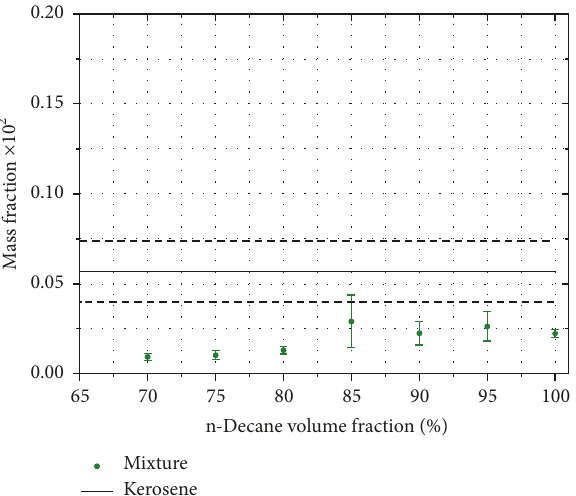
Figure 5: Comparison of mass fraction of unburned hydrocarbons (CnHm) for the surrogate and the kerosene burning.